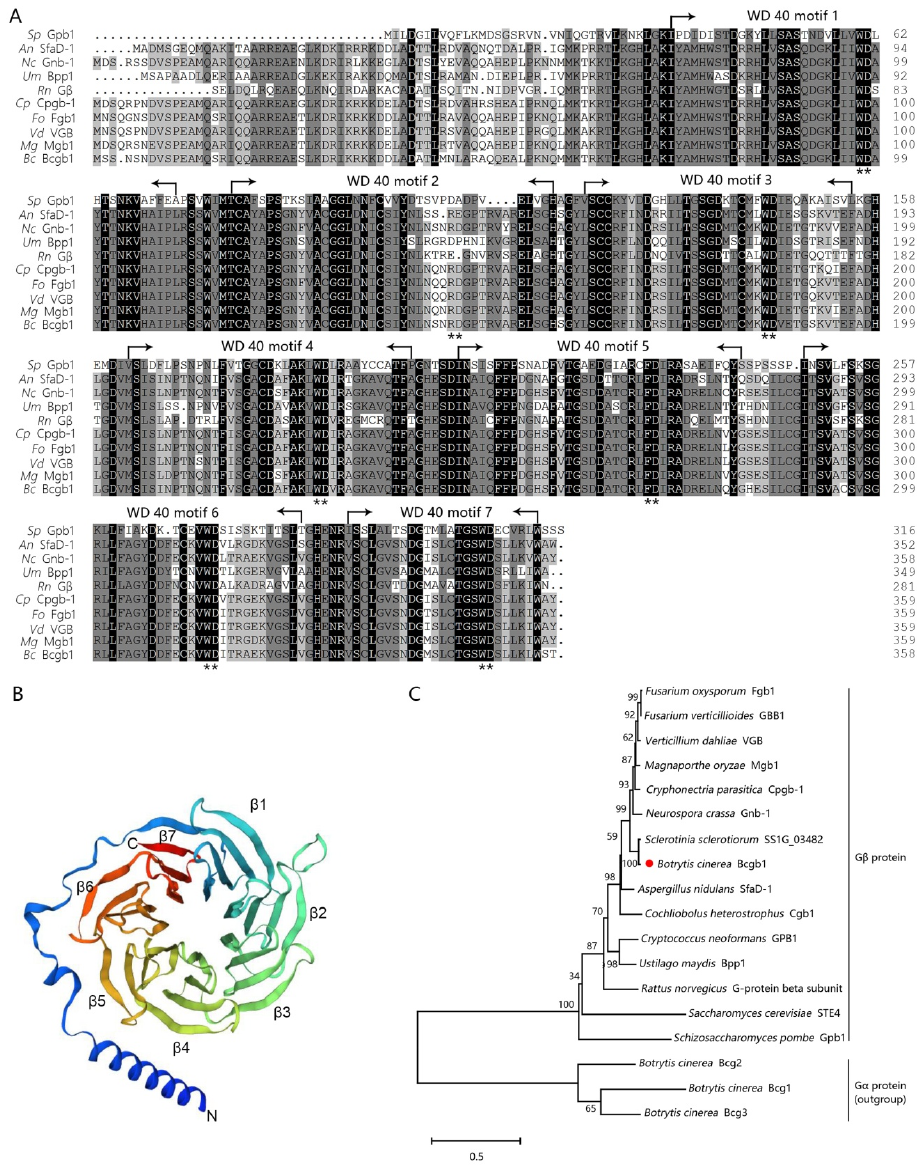
Figure 1. Sequence analysis of Bcgb1 in B. cinerea . ( A ) Amino sequence alignment of Bcgb1 orthologues. All conversed residues are shown in black and similar residues in grey. The positions of the seven WD repeats are labeled and indicated by arrows. ** means the conserved WD residues in WD repeats. ( B ) The crystal model of Bcgb1. The G β protein of R . norvegicus G β (PDB: 7cfm.1.B) was used as the template for the Bcgb1 model at the SWISS-MODEL website. The seven β -propeller blades were numbered. ( C ) A neighbor-joining tree based on amino acid sequences of G β protein in fungi. The following protein sequences were used: XP_018249805 (fgb1), ABE67098 (GBB1), XP_028497849 (VGB), BAC01165 (mgb1), XP_009851210 (gnb-1), XP_024550185 (Bcgb1), XP_001595393 (SS1G_03482), XP_024345016 (SfaD), XP_657685 (sfaD-1), AAO25585 (cgb1), AAD03596 (GPB1), XP_011386498 (bpp1), 5TDH_B ( R. norvegicus G β protein), NP_014855 (STE4), AAC37501 (gpb1), XP_024548939 (Bcg1), XP_024552854 (Bcg2), and XP_024553380 (Bcg3). Bootstrap values (%) from 1000 replicates of the data are indicated above the nodes. The red dot represents the G β protein Bcgb1 of B. cinerea in this study.